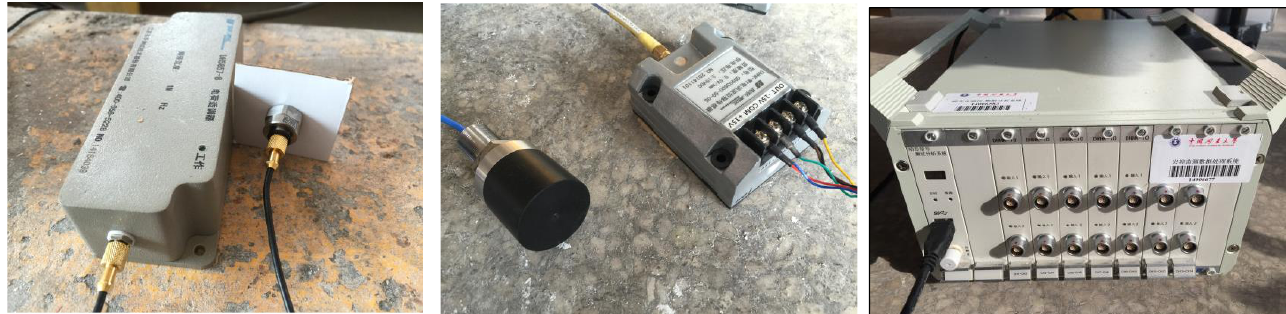
Figure 3. Ultra-dynamic signal analysis system.